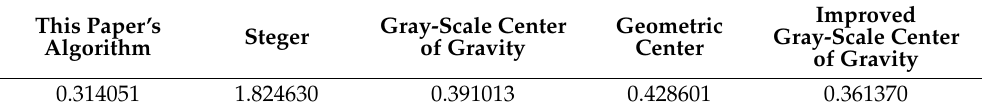
Table 2. The standard deviation of each